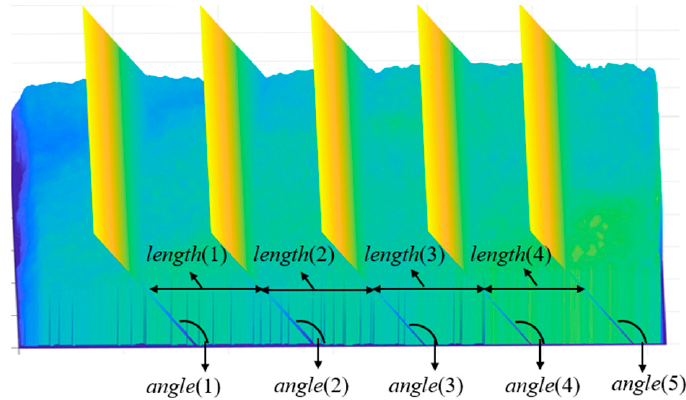
Figure 7. Schematic diagram of fish body cutting plan.